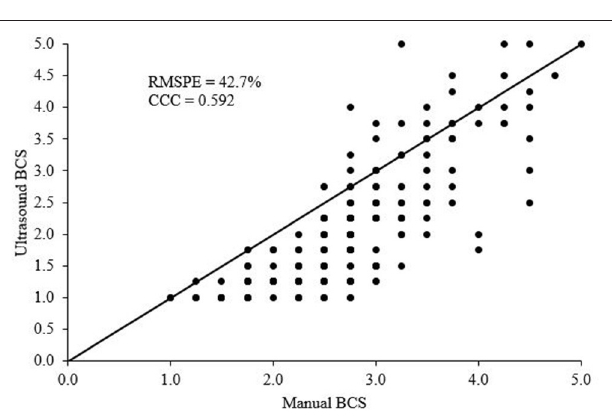
FIGURE 7 | Relationship between manual observed and ultrasound body condition score (BCS). Root mean square prediction error (RMSPE) expressed as a percentage of the observed mean for ultrasound BCS and Lin’s concordance correlation coefficient (CCC) are shown, and the 45 ◦ line through the origin.